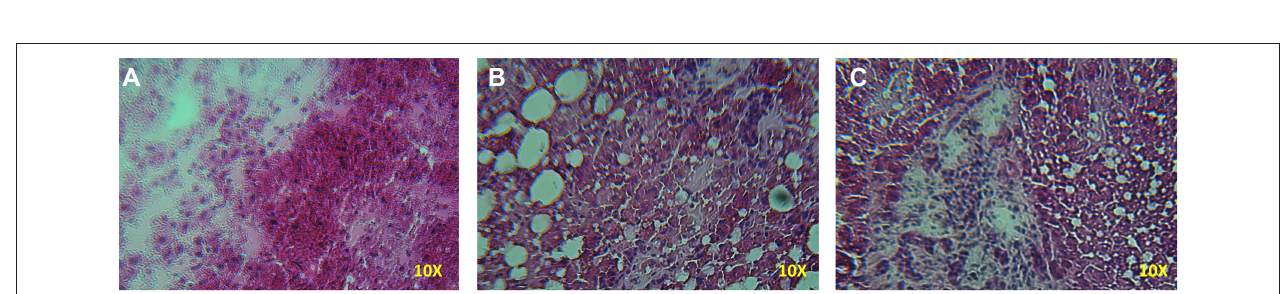
FIGURE 1 | Effect of the administration of D-galactosamine alone and of D-galactosamine + DHEA on the total distance traveled and the number of rears in the open field test after (A,B) 24 h and (C,D) 48 h of treatment; * P < 0.05, ** P < 0.01, *** P < 0.001, **** P < 0.0001.